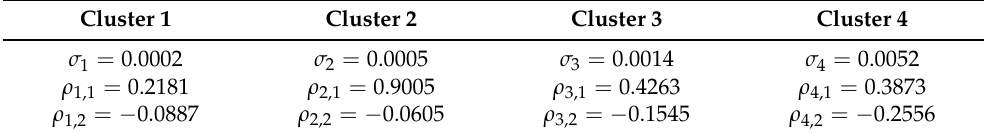
Table 2. Sigma values and correlation factors of lag 1 and lag 2, for B-spline regression mixtures. Cluster 1 Cluster 2 Cluster 3 Cluster 4 σ 1 = 0.0002 σ 2 = 0.0005 σ 3 = 0.0014 σ 4 = 0.0052 ρ 1,1 =